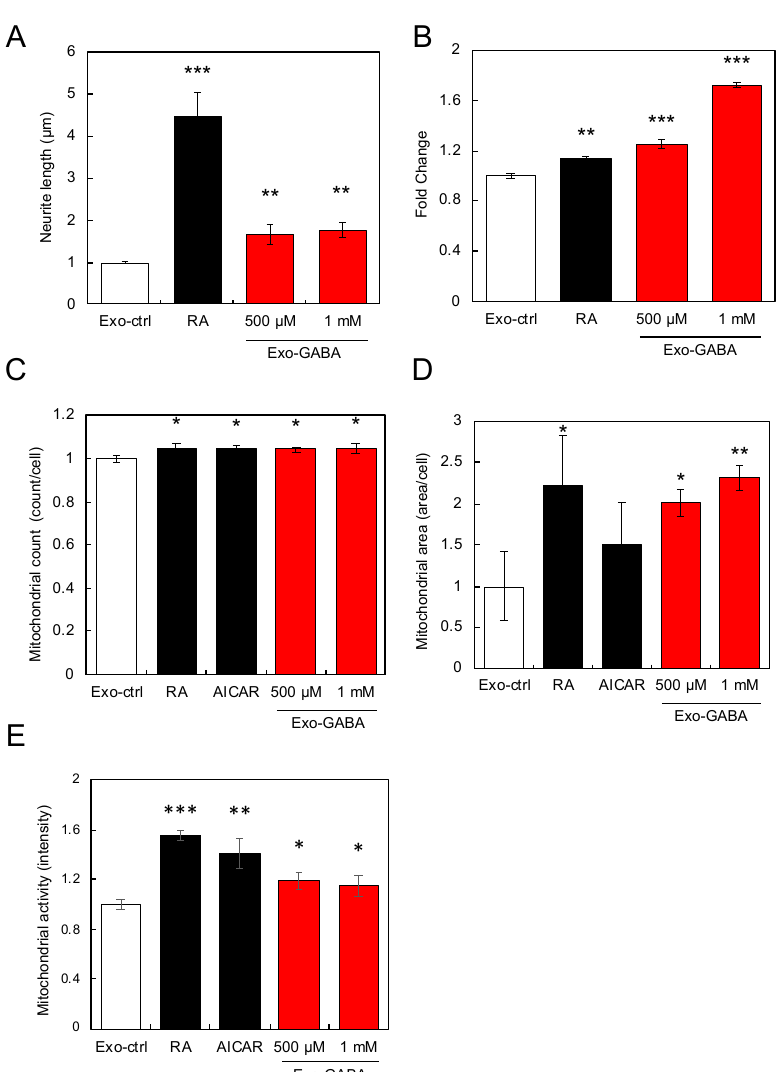
Figure 1. Exosomes derived from GABA-treated Caco-2 cells activate SH-SY5Y cells. Neurite length ( A ) and PGC-1 α expression ( B ) in SH-SY5Y cells treated with exosomes (equivalent to 90 ng protein) derived from GABA-treated Caco-2 cells. Exo-ctrl shows the exosomes derived from non-treated Caco-2 cells. Count ( C ), area ( D ), and activity ( E ) of mitochondria in SH-ST5Y cells treated with exosomes derived from GABA-treated Caco-2 cells. Retinoic acid (RA) was used as positive control. Multiple comparisons between groups were carried out by one-way ANOVA with Tukey’s post-hoc test. Statistical difference was evaluated by comparing to Exo-ctrl. Statistical significance was defined as p < 0.05 (* p < 0.05; ** p < 0.01; *** p < 0.001) (value means ± SEM, n = 3).